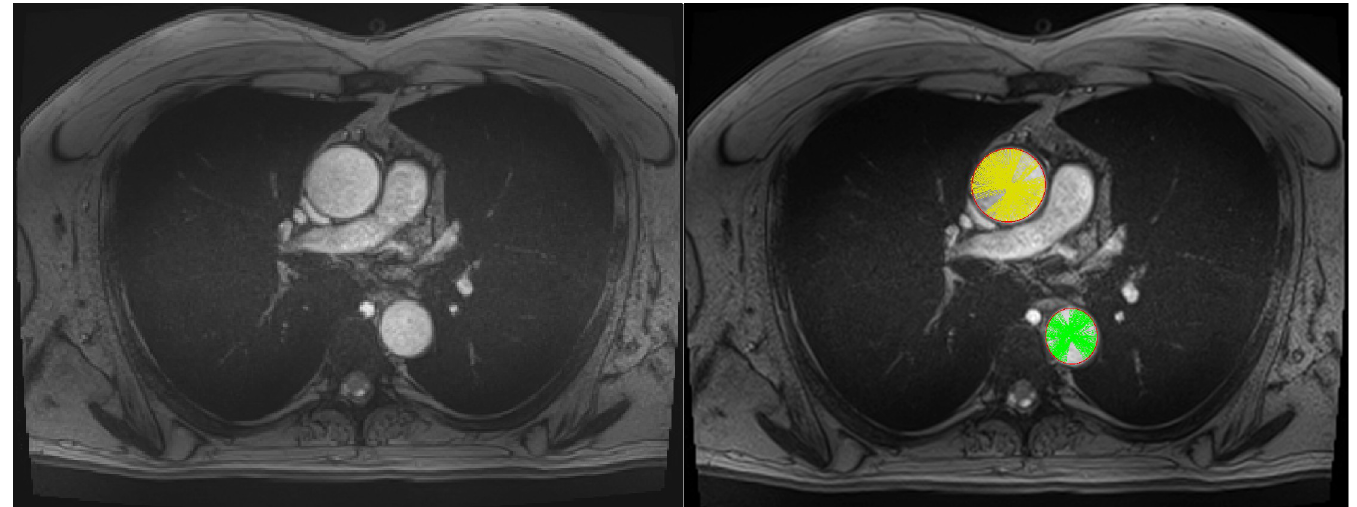
Fig 2. Automatic detection of the contours of the ascending (in green) and descending (in yellow) aortas before surgery.